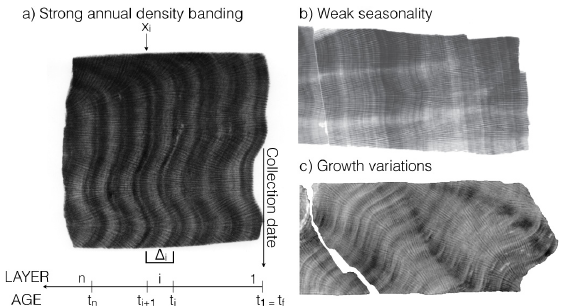
Fig. 1. Coral core X-radiographs: (a) top of a core from Mange Reef, Tanzania (Cole, unpublished). Each layer shows the chang- ing density of the coral growth over a year. Observation x i could be the δ 18 O measured from the i th layer (most likely correspond- ing to 1 i = 1year). The collection date t 1 and the oldest one t n are also shown to illustrate our notation; (b) top of a core from Onotoa, Republic of Kiribati (Thompson, unpublished) showing weak sea- sonality and annual density banding; (c) Fanning Island fossil coral V33, aged ∼ 6500 years old (Cobb et al., 2013), with a varying growth axis, which typically requires multiple sampling